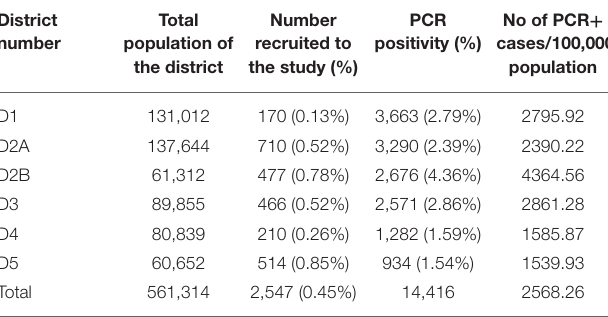
TABLE 1 | The number of individuals in each of the CMC districts and the proportion samples from each district. District